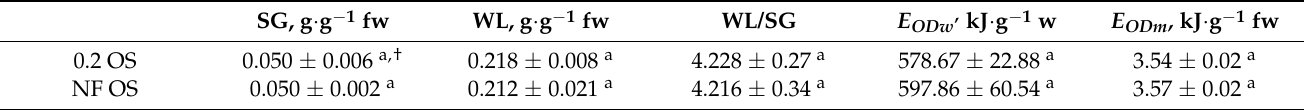
Table 1. Solid gain (SG), water loss (WL), water loss to solid gain ratio (WL/SG) and specific energy consumption ( E ODw ) during osmotic dehydration in filtrated (0.2 OS) and non-filtrated (NF OS) osmotic solutions (OS). SG, g · g − 1 fw WL, g · g − 1 fw WL/SG 0.2 OS NF